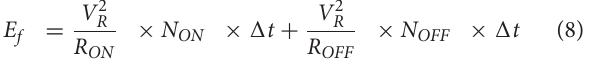
TABLE 1 | Recognition rate on MNIST varying with